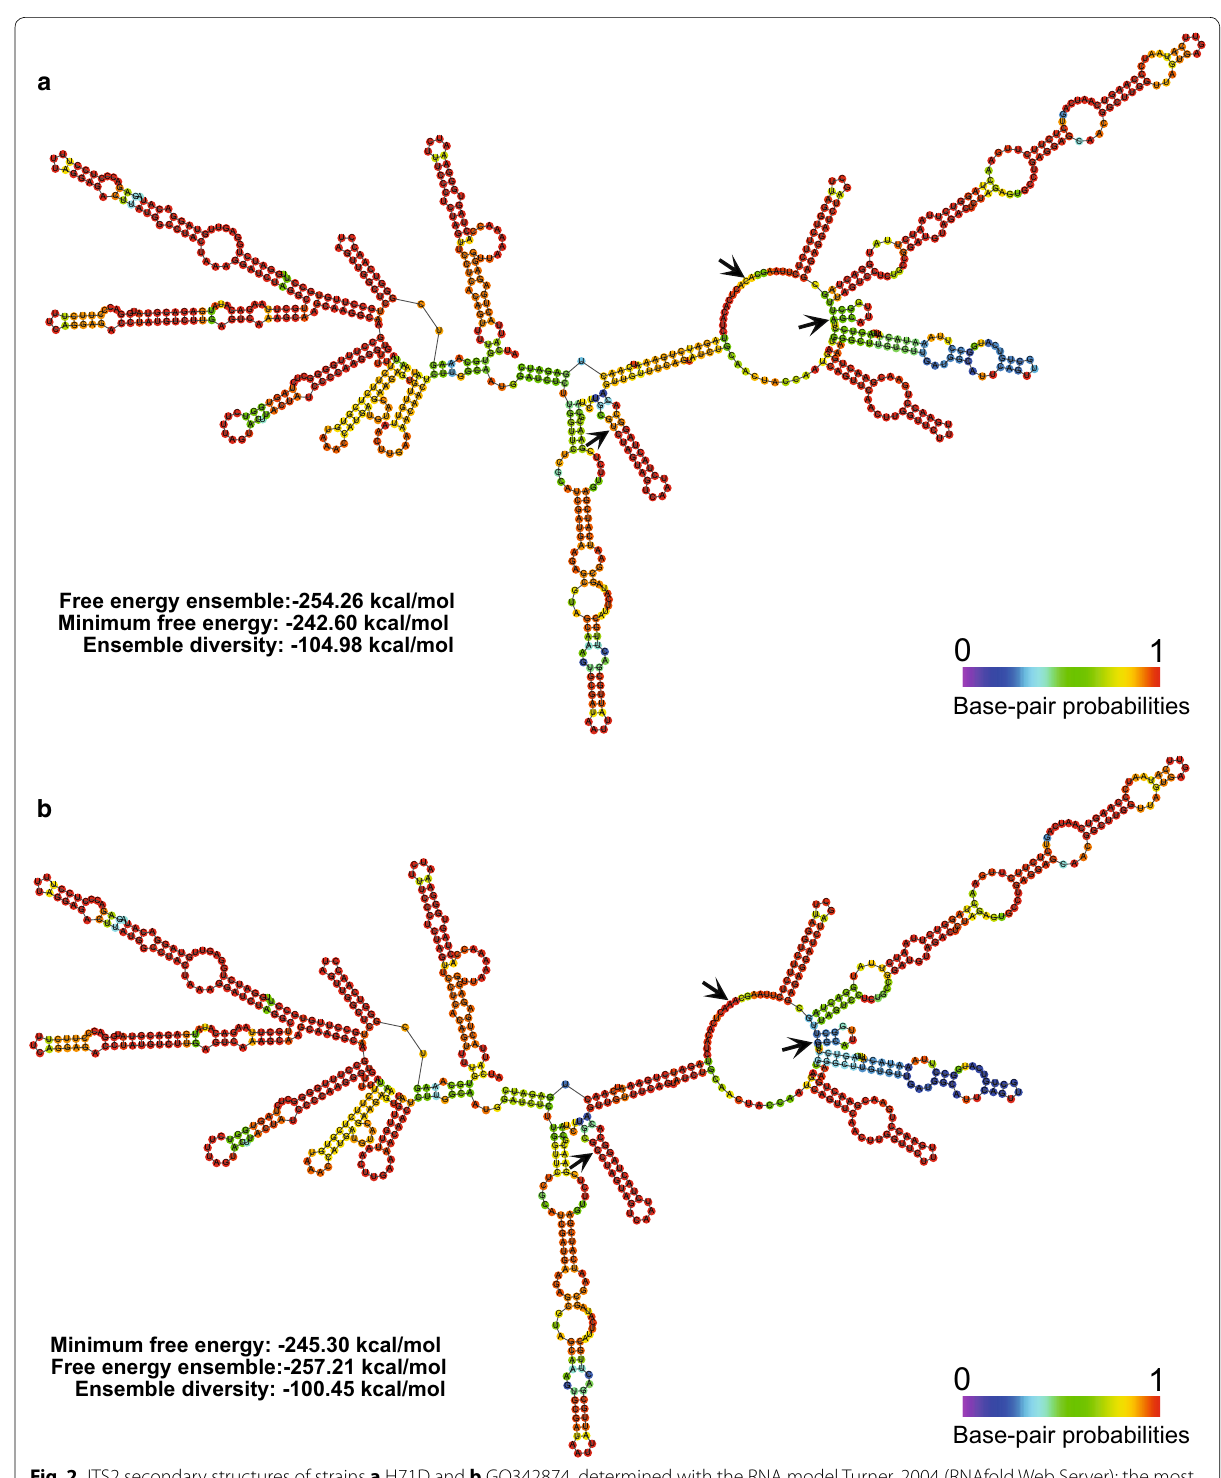
Fig. 2 ITS2 secondary structures of strains a H71D and b GQ342874, determined with the RNA model Turner, 2004 (RNAfold Web Server); the most significant differences in the sequences that determined the secondary structure are indicated with black